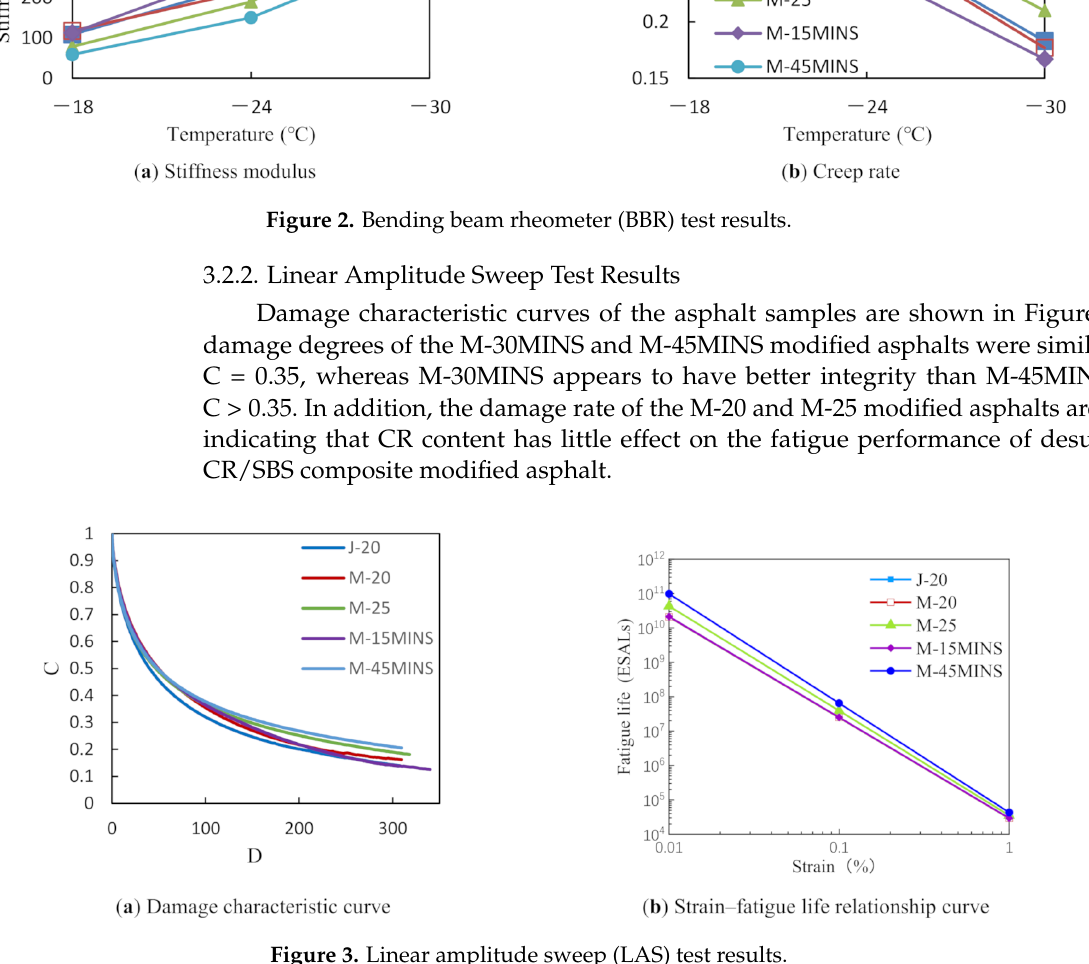
Figure 3. Linear amplitude sweep (LAS) test